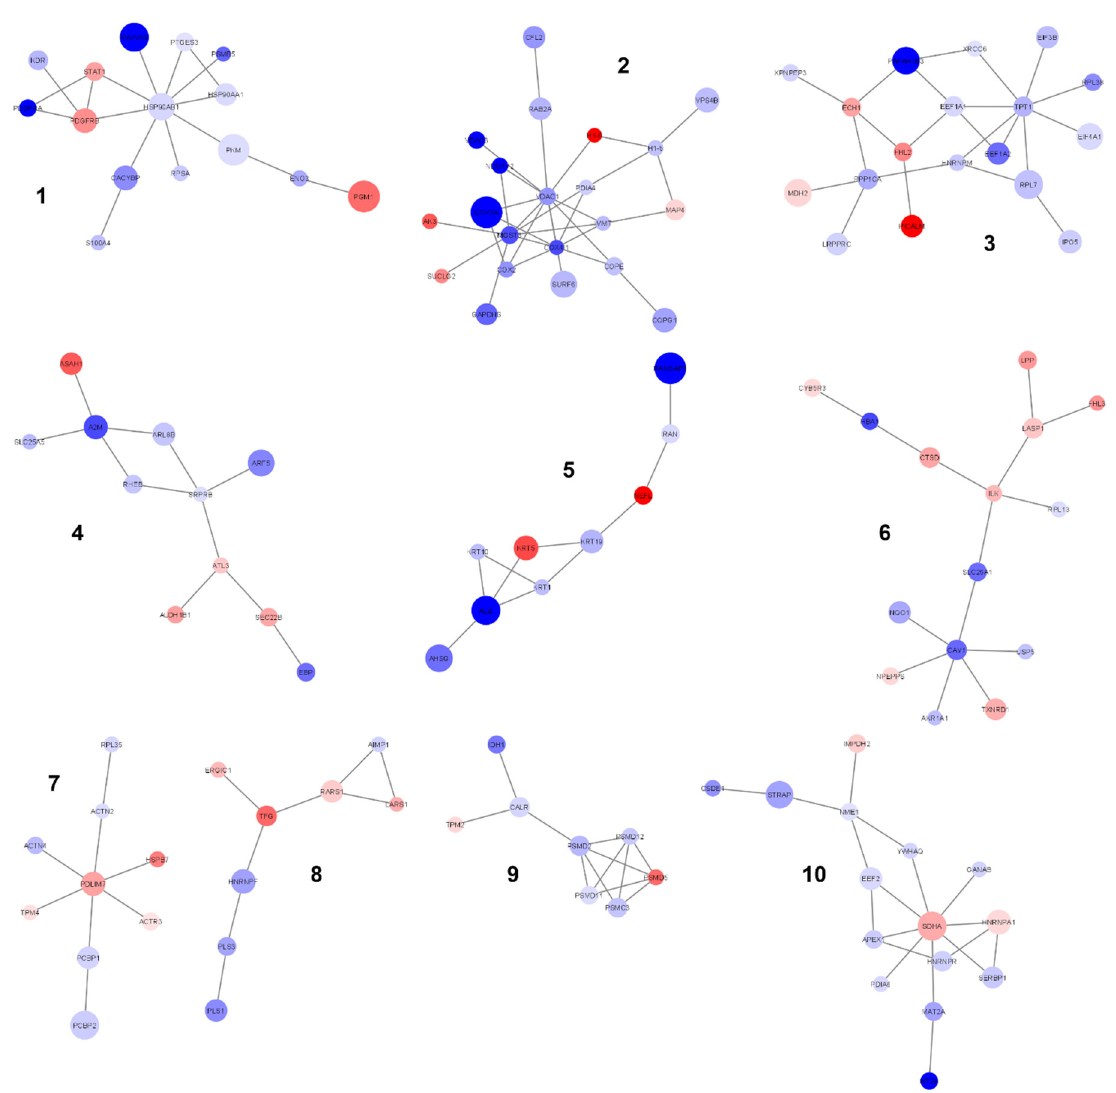
Figure 6. Sub-clusters obtained by the segmentation of the main component. Ten sub-clusters are shown. Node color is associated with the FC. Blue: proteins downregulated in ALS_C9 vs. ALS_N; red: proteins upregulated in ALS_C9 vs. ALS_N. Node size is proportional to the statistical significance.